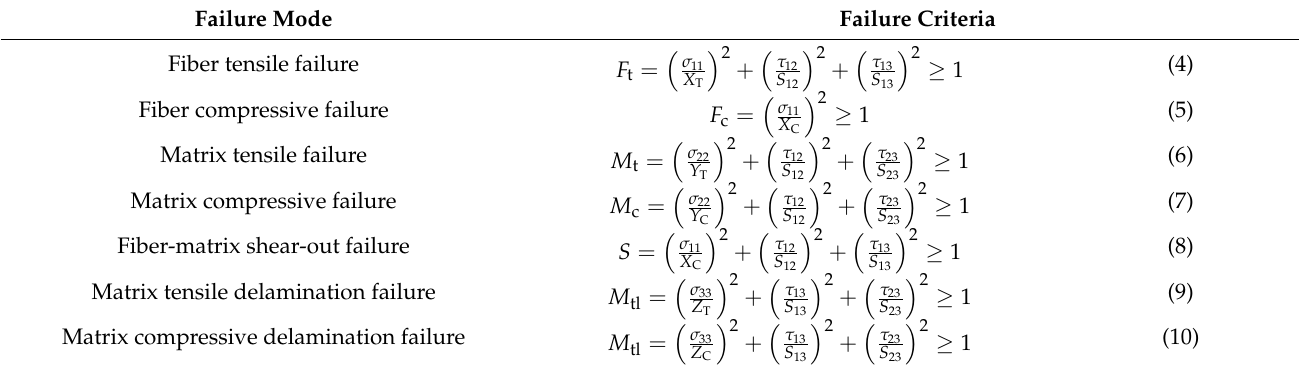
Table 1. Hashin three-dimensional failure criterion.